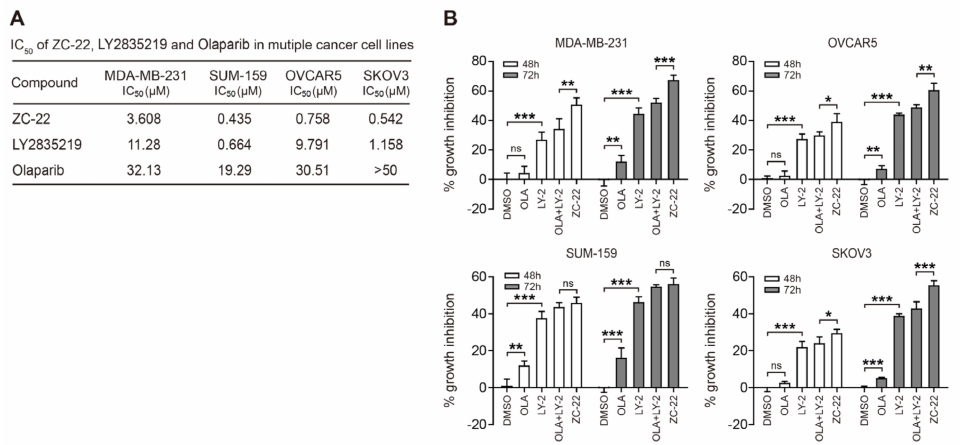
Figure 2. ZC-22 suppresses proliferation of breast and ovarian cancer cells. ( A ) IC 50 of ZC-22, Olaparib, and LY2835219 (Abemaciclib) in breast and ovarian cancer cells. Cells were treated with increasing concentrations of ZC-22, Olaparib, or LY2835219 for 6 days with replenishment of medium every 2 days. Cell proliferation was analyzed by CCK-8 assays. ( B ) Cell proliferation assay of breast and ovarian cancer cells with indicated treatment. MDA-MB-231 cells were treated with 2 µ M Olaparib (OLA) or LY2835219 (LY-2) alone or together (OLA + LY-2) or with ZC-22 alone for 48 or 72 h. SUM-159, OVCAR5, and SKOV3 cells were treated with 0.5 µ M OLA or LY-2 alone or together or with ZC-22 alone. Cell proliferation assay was analyzed by CCK-8 assays. Values are means ± SD, n = 3. ns, not significant, * p < 0.05, ** p < 0.01 and *** p < 0.001 for comparisons with the DMSO-treated group using an unpaired t